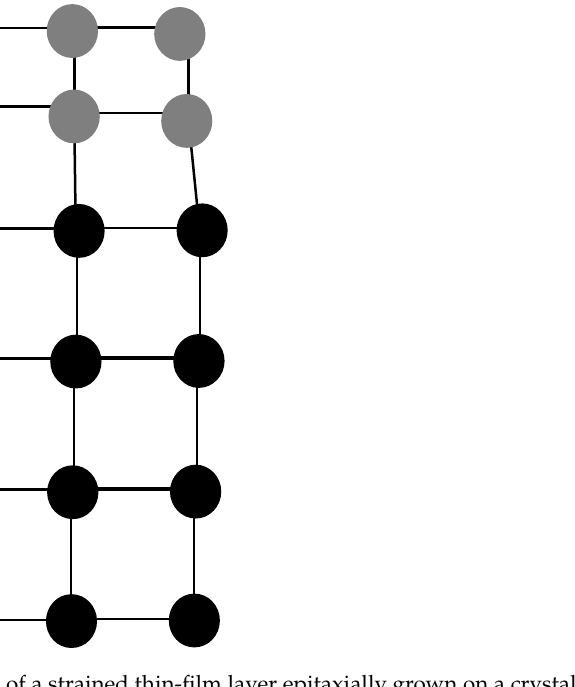
Figure 2. Illustration of a strained thin-film layer epitaxially grown on a crystalline substrate. Another source of intrinsic residual stresses in deposited polycrystalline thin-film lay- ers is the presence of crystalline grains. Often thin-film layers are deposited at temperatures where it is thermodynamically favorable for the material layer to form micro-crystalline grain structures during growth. These grains can grow in size during the thin-film depo- sition processes and often exhibit irregular-shaped columnar structures with diameters that increase through the thickness of the material layer thereby resulting in a residual stress